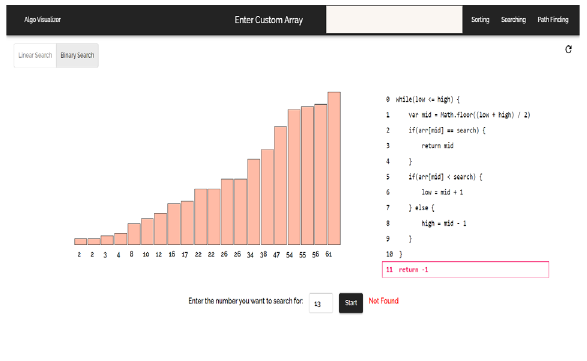
Fig.6. Binary Search Animation